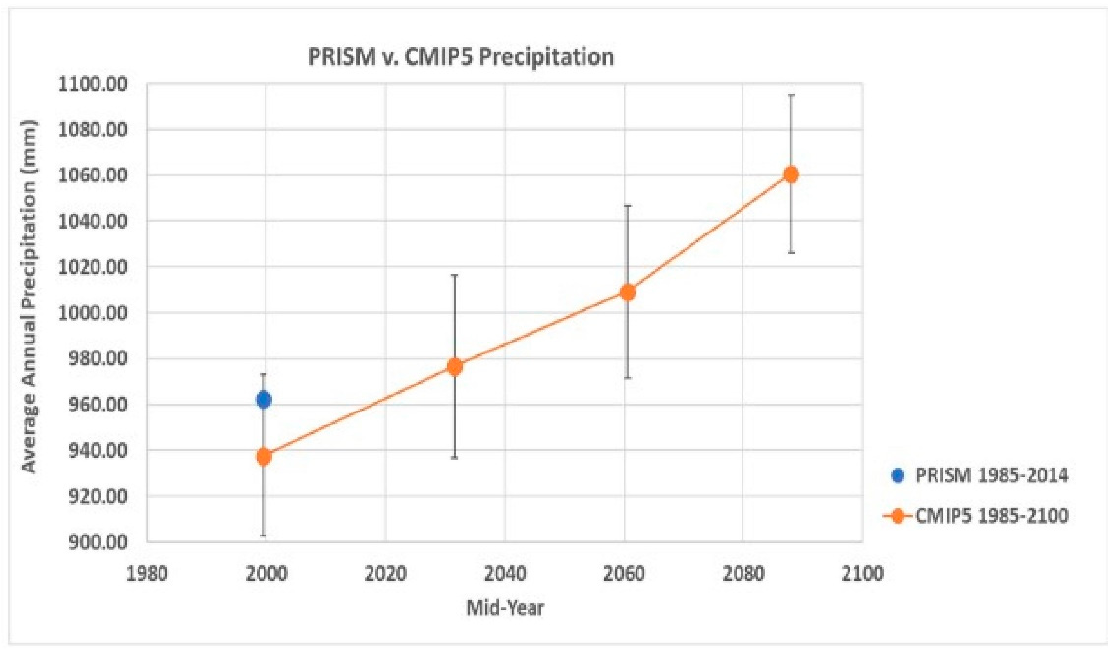
Figure 2. PRISM vs. Average of 20 CMIP5 GCMs precipitation.